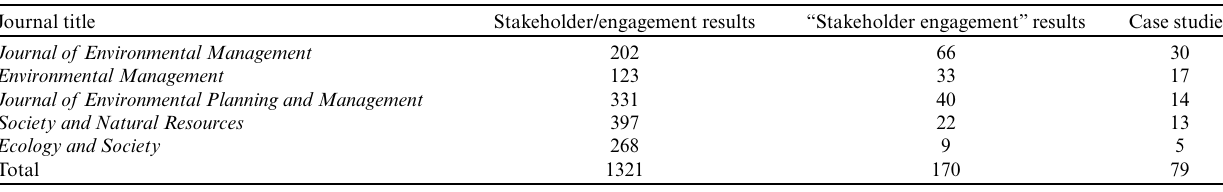
Table 1 . Journals analyzed and search results as of May